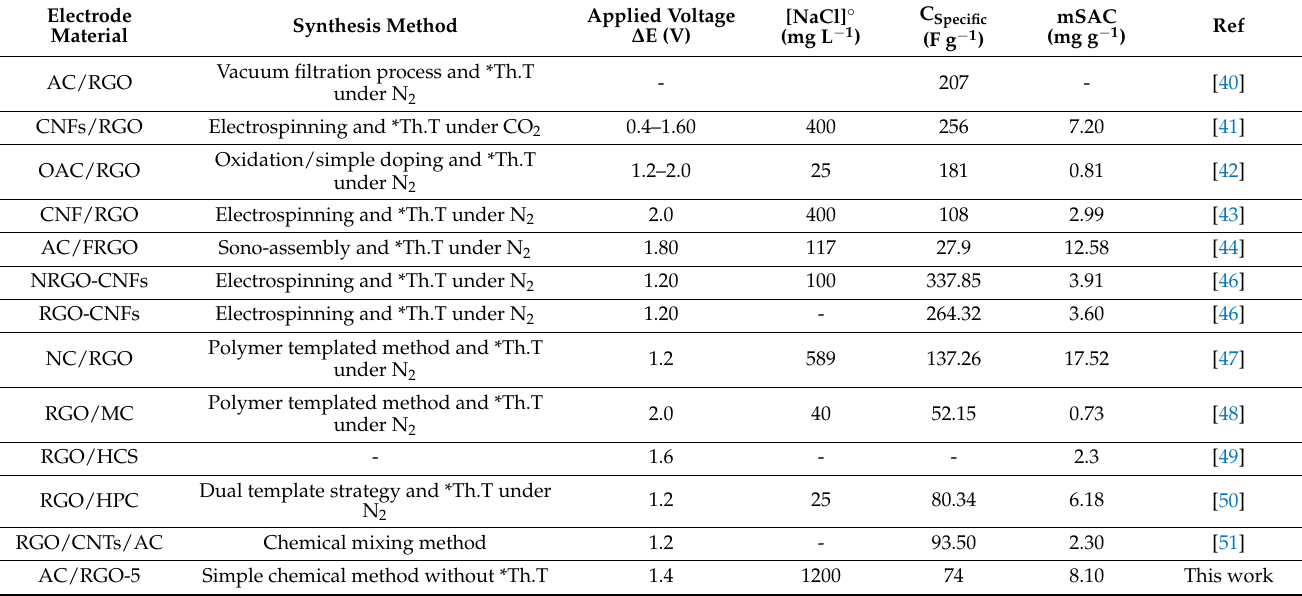
Table 4. Advances in electrosorption of AC/RGO composite electrodes in CDI.